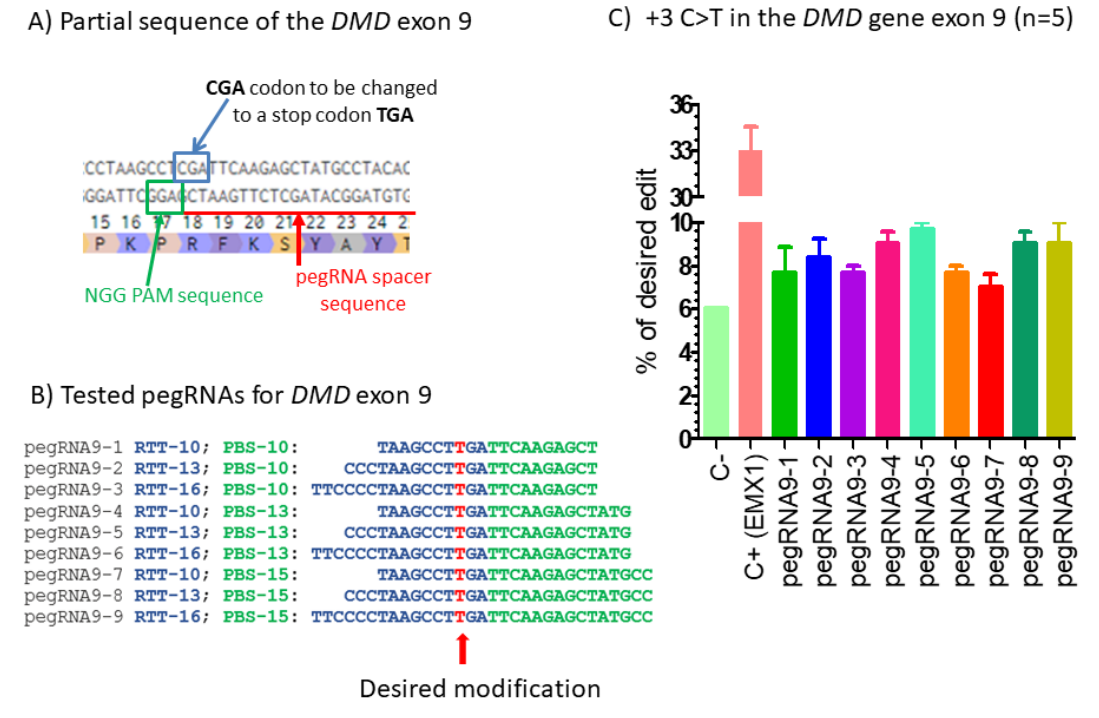
Figure 1. Prime editing of DMD exon 9. ( A ) Partial sequence of exon 9 of the DMD gene. The SpCas9n-RT PAM is in a green box and the pegRNA protospacer sequence is underlined in red. ( B ) The sequences 5 (cid:48) to 3 (cid:48) of the Primer Binding Site (PBS, in green) and of the Reverse Transcriptase Template (RTT, in blue) of 9 pegRNAs targeting DMD exon 9. The T in red in the RTT permits introducing an adenosine ( A ) in the strand containing the PAM (in the present case the antisense strand). This results in the presence of a thymine in the sense strand modifying the arginine codon (CGA) into a stop codon (TGA). ( C ) Results of Sanger sequencing and EditR analysis of prime editing of the DMD exon 9. There was a high background level (6%) of thymidine (T) in the position of the targeted nucleotide. However, pegRNA9-2 to pegRNA9-9 increased the percentage of T up to 10%. A control pegRNA-EMX1 targeting the EMX1 gene produced a 33% modification in that gene. The experiments were carried out in five independent replicates ( n =